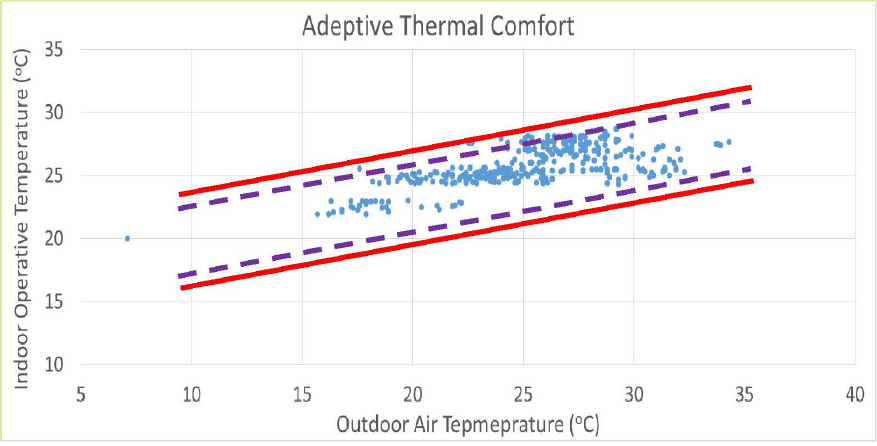
Figure 15. Meeting “Adaptive” thermal comfort over the course of a year